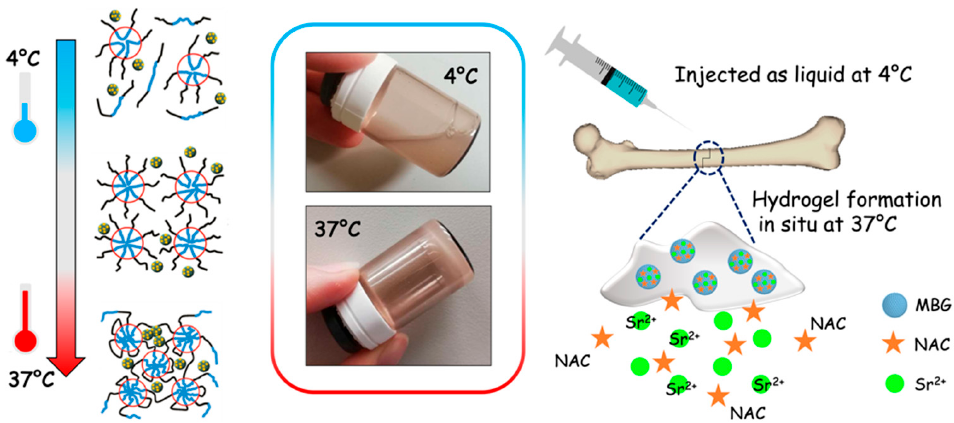
Figure 1. The thermo-responsive hydrogel as an injectable platform for the co-delivery of strontium ions and NAC from incorporated MBGs.